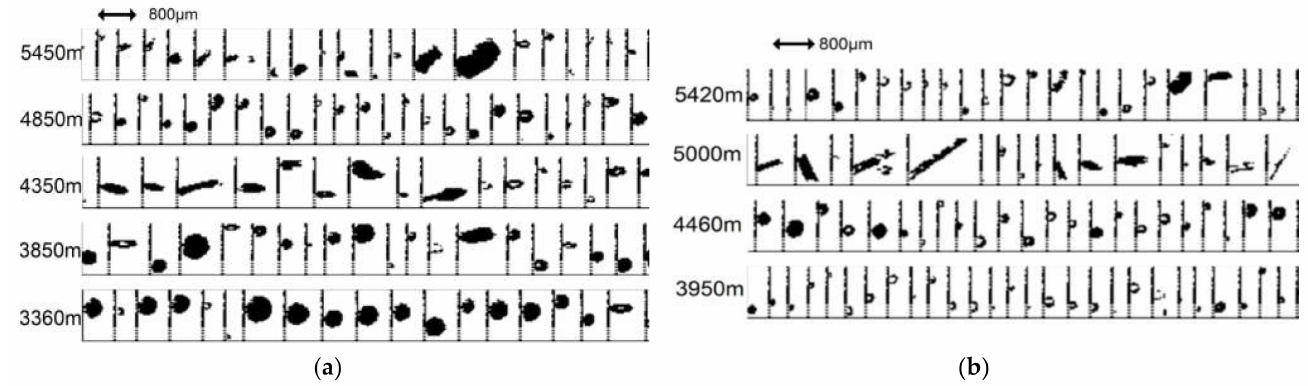
Figure 9. 2D-C images at selected heights during ( a ) the first Baicheng Y-12 aircraft flight and ( b ) the second Baicheng Y-12 aircraft flight.